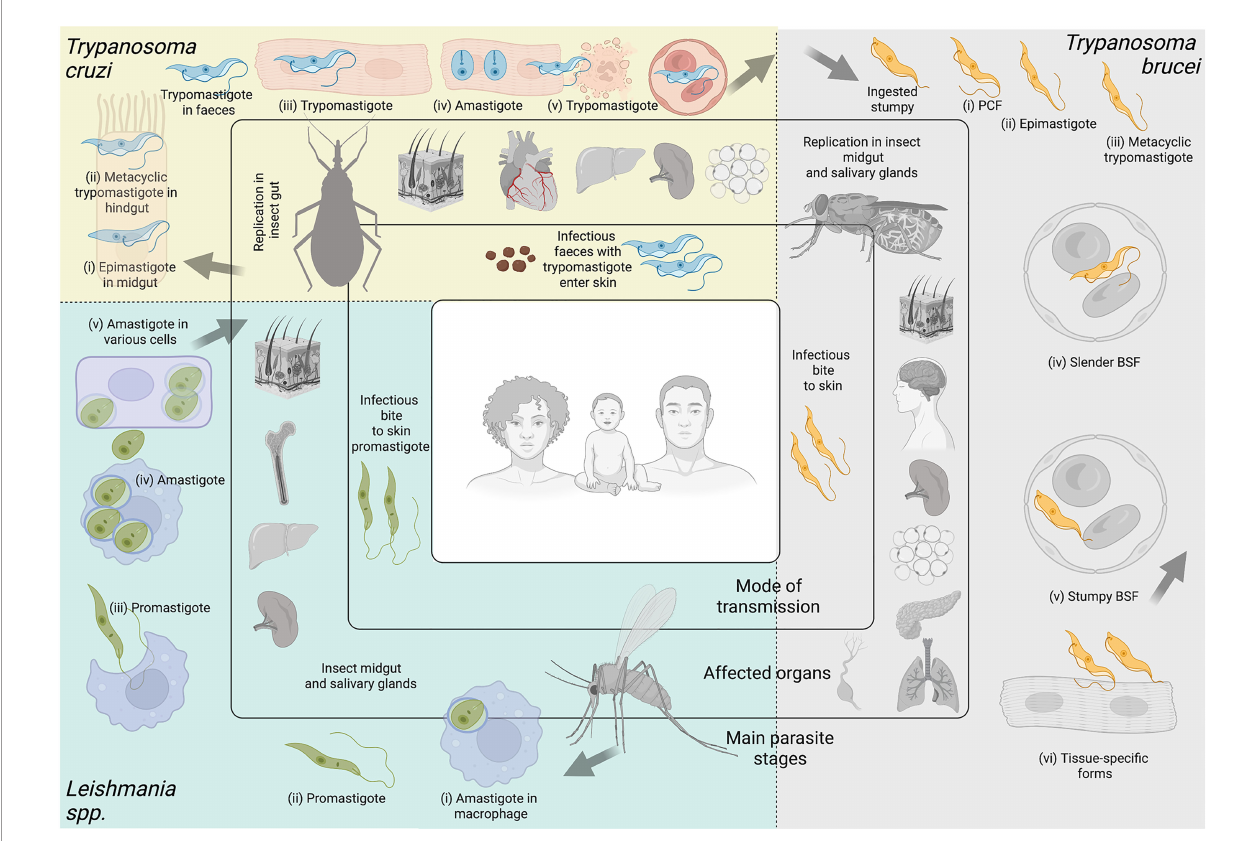
FIGURE 2 | Kinetoplastid parasites. Kinetoplastid parasites have complex life cycles with various stages occurring in insect vector and mammalian hosts, and in different organs or tissues within their hosts. While advances have been made to culture several stages of these organisms in vitro , many are restricted to short-term culture. For others, only a limited number of stages can be sustained. Equally, not all stages are amenable to genetic modi fi cation. In this fi gure we summarize main features of Trypanosoma cruzi, Trypanosoma brucei , and Leishmania spp. Trypanosoma cruzi. Triatomine insect vectors of the genera Triatoma, Rhodnius and Panstrongylus become infected by feeding on infected blood (from humans or other animals). Ingested trypomastigote metacyclics transform into (i) epimastigotes in the insect ’ s midgut. These multiply and differentiate into (ii) metacyclic trypomastigotes in the hindgut. Infected vectors release trypomastigotes through their faeces on the host skin. Parasites enter the skin via wounds or mucosal membranes (such as through the eyes). Inside the host, (iii) trypomastigotes invade cells of a plethora of tissues, and transform into (iv) amastigotes which multiply and differentiate again into trypomastigotes, which are released from lysed cells. Some of these travel in the (v) bloodstream, and can be ingested by triatomine vectors upon a bite for blood feeding. The most commonly affected organ is the heart, but others, including the liver, spleen, and adipose tissues are invaded too, some of them becoming important parasite reservoirs. Among these T. cruzi stages, epimastigotes, trypomastigotes and amastigotes can be cultured in vitro in large amounts, and the whole life cycle can be modeled in vitro . Epimastigotes, trypomastigotes and amastigotes are amenable to genetic modi fi cation. Trypanosoma brucei. Tsetse fl ies (from the genus Glossina ) become infected by feeding on infected blood (from humans and other animals). Within the fl y ’ s midgut, T. brucei stumpy forms transform into (i) procyclic trypomastigotes (PCF). These multiply, egress from the midgut, and transform into (ii) epimastigotes, which can reach the fl y ’ s salivary glands and continue to multiply. (iii) Metacyclic trypomastigotes are injected into the host skin during a bloodmeal. Inside the host, they transform into bloodstream form (BSF) trypomastigotes that can be (iv) slender or (v) stumpy forms, the latter of which rapidly transforms into procyclic forms in the tsetse midgut upon a blood meal. While slender BSFs multiply and thrive in the bloodstream, T. brucei is an extracellular parasite capable of invading multiple organs including the brain, spleen, adipose tissue, pancreas, lungs and lymphatic vasculature. These (iv) tissue-speci fi c forms are relatively poorly understood. Among these Trypanosoma brucei stages, procyclics and BSFs can be cultured in vitro in large amounts, and the same stages are amenable to genetic modi fi cation. Leishmania spp. Phlebotomine sand fl ies become infected by ingesting infected cells during a bloodmeal. Within the sand fl y, (i) amastigote forms of Leishmania spp. transform into (ii) promastigotes, which develop in the vector ’ s gut, and migrate to the proboscis. Infected sand fl ies transmit (iii) promastigotes during a bloodmeal. After entry into the skin, promastigotes are ingested by phagocytic cells (eg. macrophages and neutrophils). Within these cells, promastigotes transform into (iv) amastigotes, which multiply and (v) infect other cells. Depending on parasite and host factors, cutaneous or visceral leishmaniasis can result. For the former, the skin and soft tissues like the nose and mouth can be affected. For the latter, affected organs commonly include the spleen, liver and bone marrow. Among these Leishmania spp. stages, promastigotes, axenic amastigotes and intracellular amastigotes can be cultured in vitro in large amounts. Promastigoes and amastigotes are amenable to genetic modi fi cation. Note Large arrows refer to the completion of the cycle. Figure created with